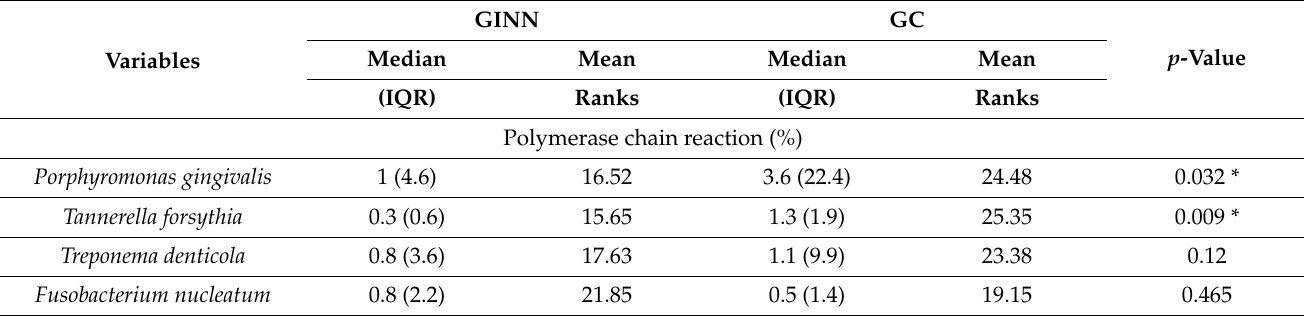
Table 3. Comparison of mean ranks of outcome variables between the gingivitis groups.